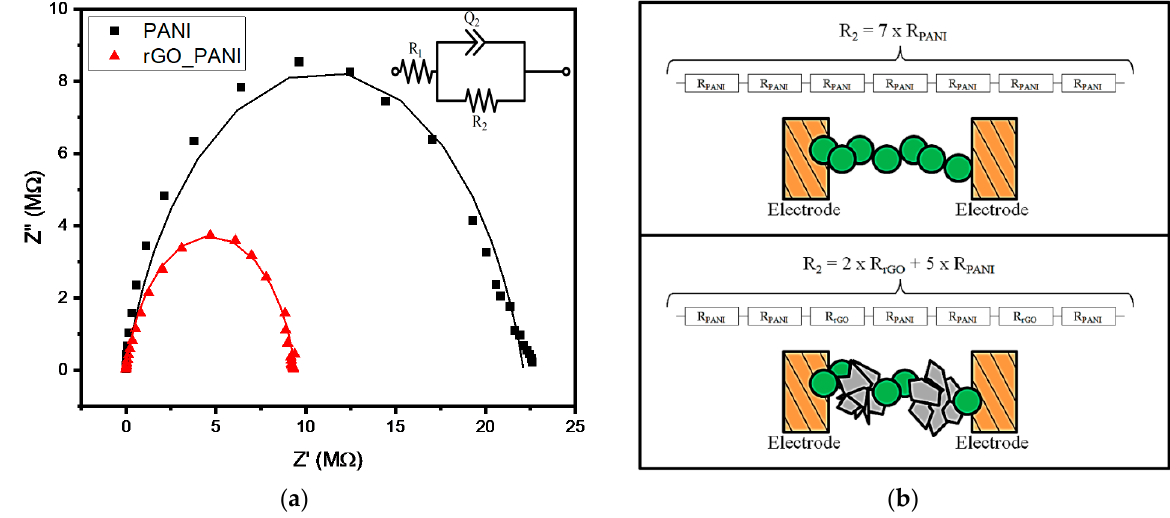
Figure 6. Nyquist plot ( a ) with experimental data (symbols) and fit from the equivalent circuit (dashed lines), inset: equivalent circuit. On ( b ), a schematic representation of PANI and rGO-PANI between the electrodes.